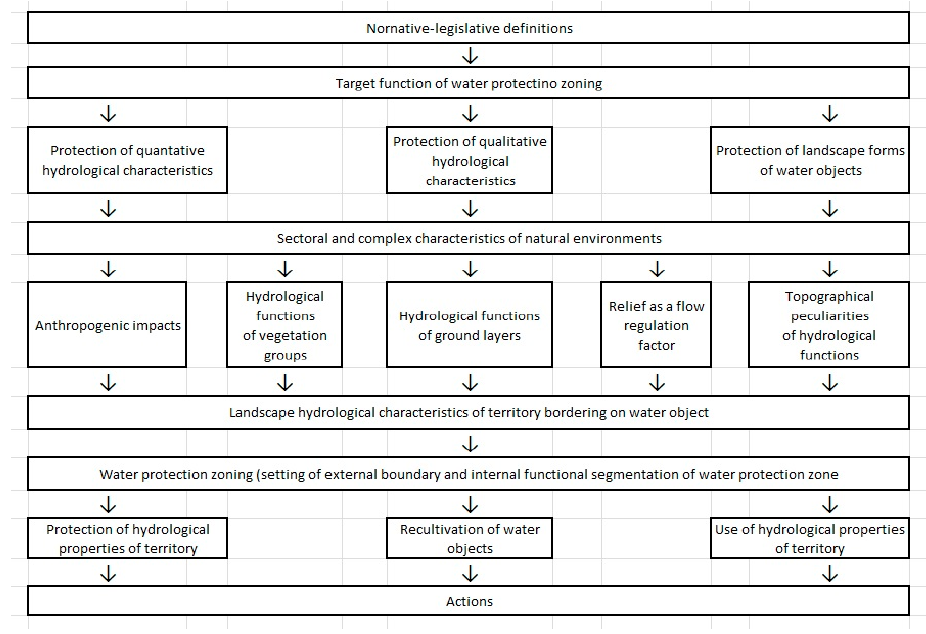
Figure 4. Design scheme of the Lake Baikal water protection zone [8].